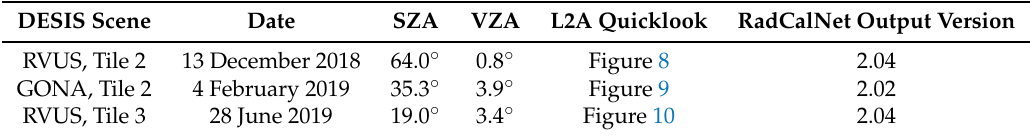
Table 4. Example of DESIS scenes of RadCalNet sites used for TOA-L validation within this study. SZA, solar zenith angle; VZA, sensor view zenith angle; RVUS, Railroad Valley, USA; GONA, Gobabeb, Namibia.